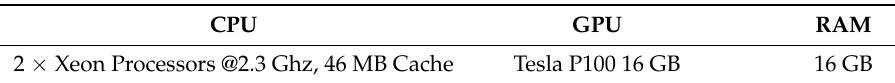
Figure 14. Flowchart showing division of the data augmentation dataset for model training. Table 3. The training system.